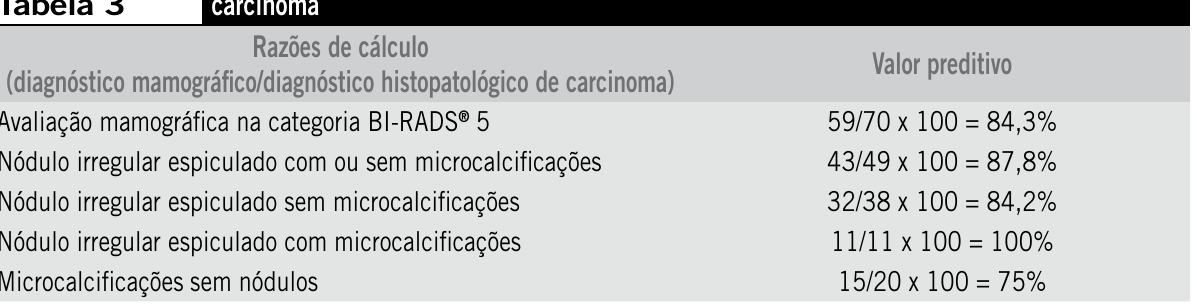
(diagnóstico mamográfico/diagnóstico histopatológico de carcinoma) Avaliação mamográfica na categoria BI-RADS ® 5